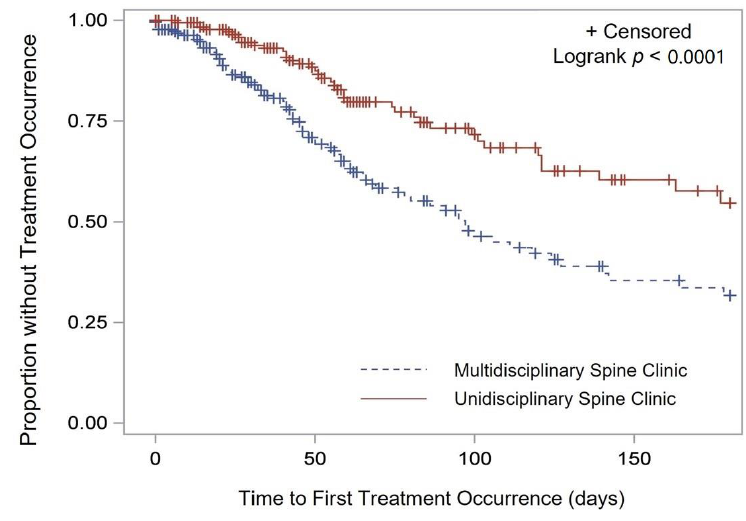
Figure 1. Time to injection order ( top ) and occurrence ( bottom ).